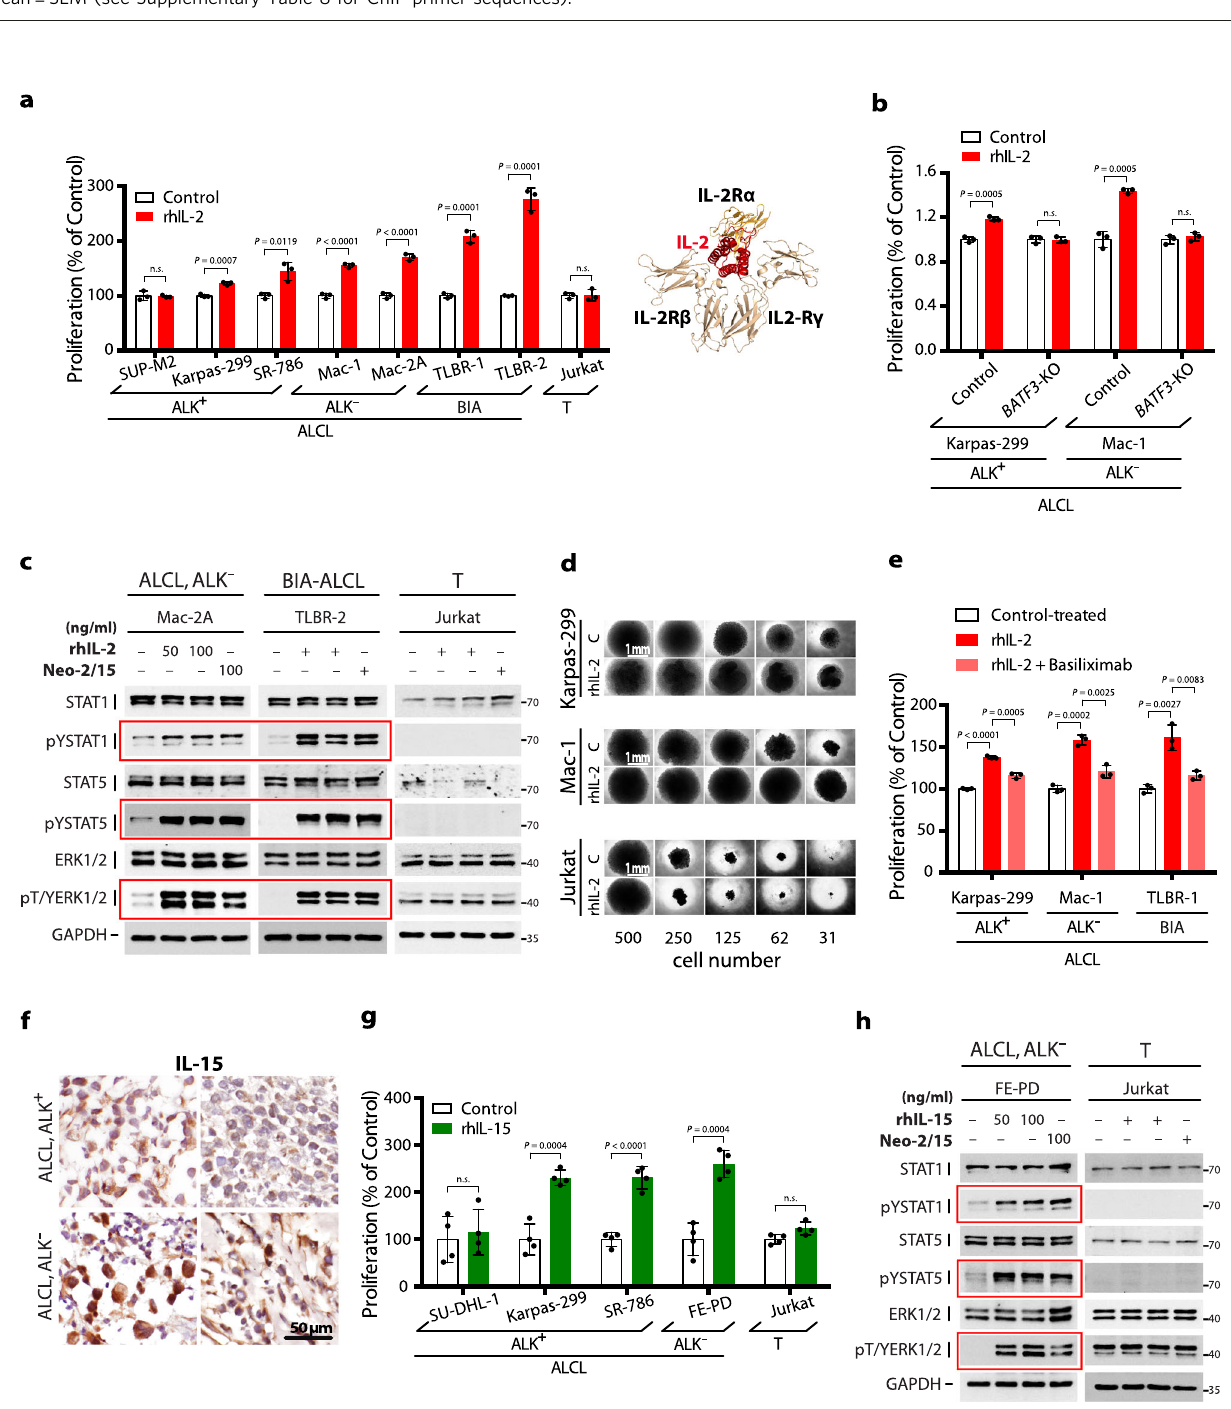
Fig. 2 BATF3 regulates expression of IL2R subunits and CD30 in ALCL. a IL2RA , IL2RB and IL2RG mRNA expression in cell line panel consisting of 13 ALCL cell lines (6 ALCL, ALK + , 4 ALCL, ALK − and 3 BIA-ALCL), 4 T-cell leukemia-derived control cell lines (T) and PBMCs, or in b CRISPR/Cas9-mediated BATF3 -KO and CRISPR control ALCL cells, using quantitative RT-PCR. Data are indicated as means ± SD of biological triplicates. P values were determined by two-tailed unpaired Student ’ s t test. c Cell surface expression of CD30 in BATF3 -KO (red) or CRISPR control (green) ALCL cells, isotype control (gray) and unstained cells (black). d BATF3 ChIP of the CD30 regulatory region as compared to a control region (Ref_Ch4). Combined data of two biological replicates are shown as mean ± SEM (see Supplementary Table 8 for ChIP primer sequences). e ChIP-seq tracks at the CD30 locus for BATF3 and H3K27ac in ALCL cell lines with indicated SE regions. f Electrophoretic mobility shift assay (EMSA) of AP-1 TRE complexes on the IL2RA promoter or IL2RB enhancer region (see Supplementary Table 8 for probe sequences) in 10 ALCL cell lines and 4 T-cell leukemia-derived control cell lines. The positions of AP-1 complexes, nonspeci fi c bands (n.s.) and free probes are indicated. Blots shown are representative of three independent experiments with similar results. g BATF3 ChIP on IL2RA or IL2RB regulatory regions as compared to a control region (Ref_Ch4). Combined data of two biological replicates are shown as mean ± SEM (see Supplementary Table 8 for ChIP primer